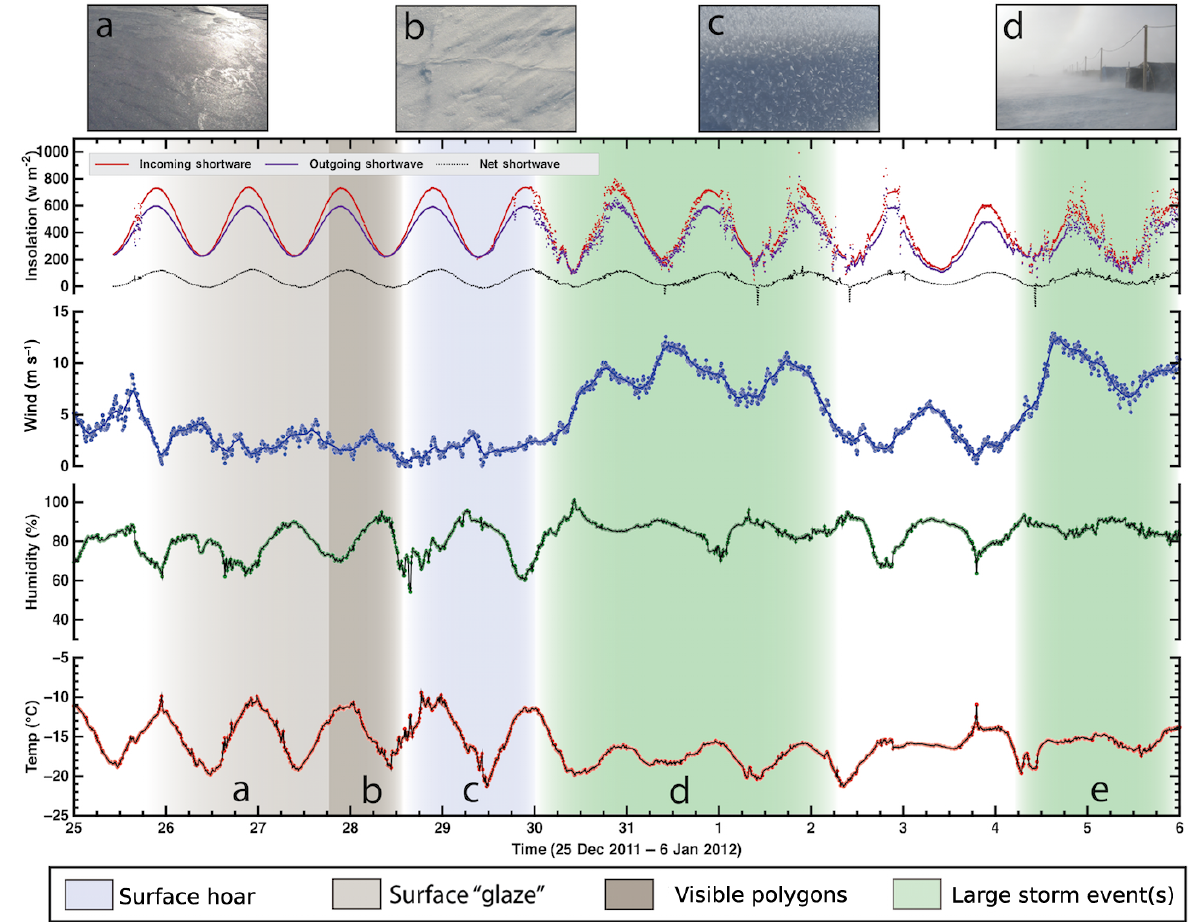
Figure 7. Surface evolution over 12 days in the 2011–2012 season, and AWS data. Shading shows episodes of surface hoar, glazes, and polygonal cracking; storm events are also shown. Letters near the top refer to photographs above of specific features or events. All dates and times are GMT (WAIS local time − 12h). The errors for all AWS instruments are listed in Table